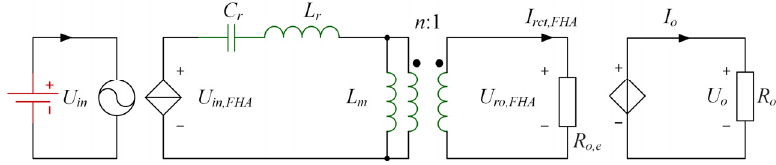
Figure 2. Ideal equivalent circuit of LLC resonant converter